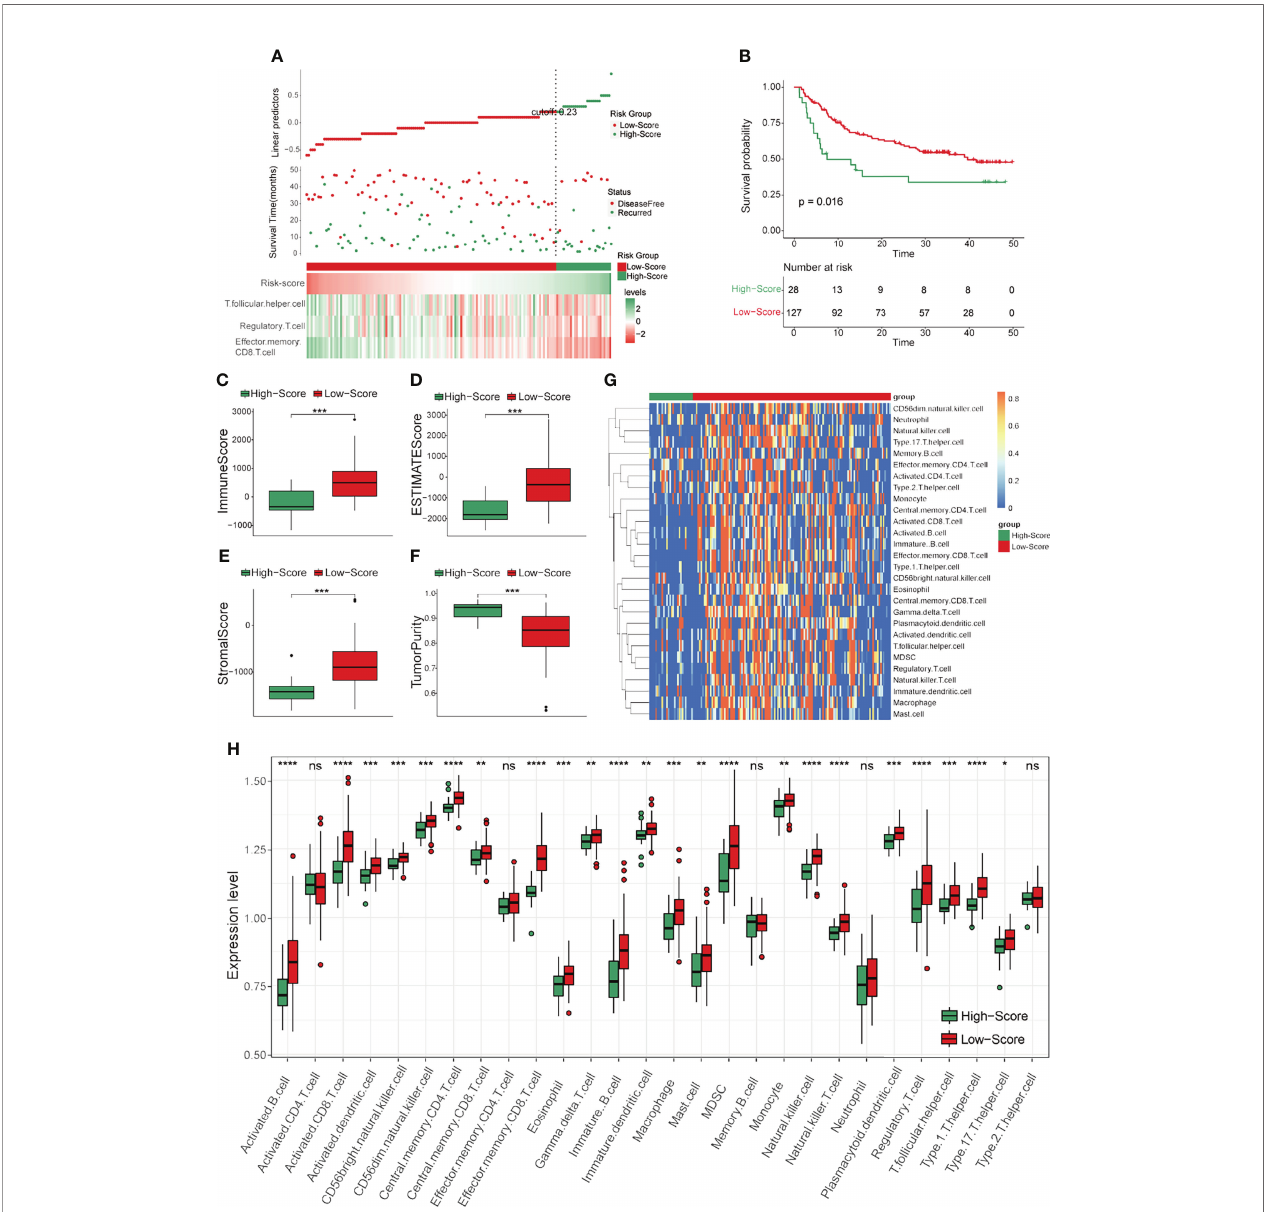
FIGURE 3 | External validation of the TCRS ef fi ciency in validation cohort 1. (A) Survival status and abundances effector memory of CD8 T cells, regulatory T cells and follicular helper T cells for the high- and low-score groups. (B) Kaplan-Meier curve for the two groups in the validation cohort 1. (C – F) The expression levels of the immune score (C) , ESTIMATE score (D) , stromal score (E) and tumor purity (F) for the two groups. (G, H) The expression levels of 28 immune cells of the two groups visualized by heatmap (G) or boxplot (H) . *p < 0.05, **p < 0.01, ***p < 0.001, ****p < 0.0001, ns: not signi fi